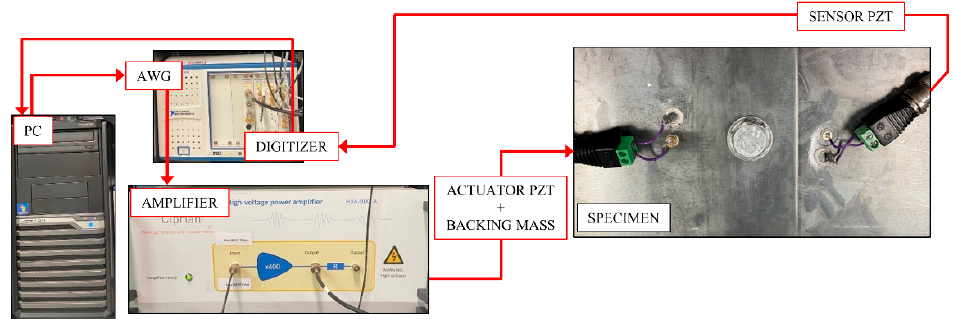
Figure 4. Signal generation and acquisition setup.